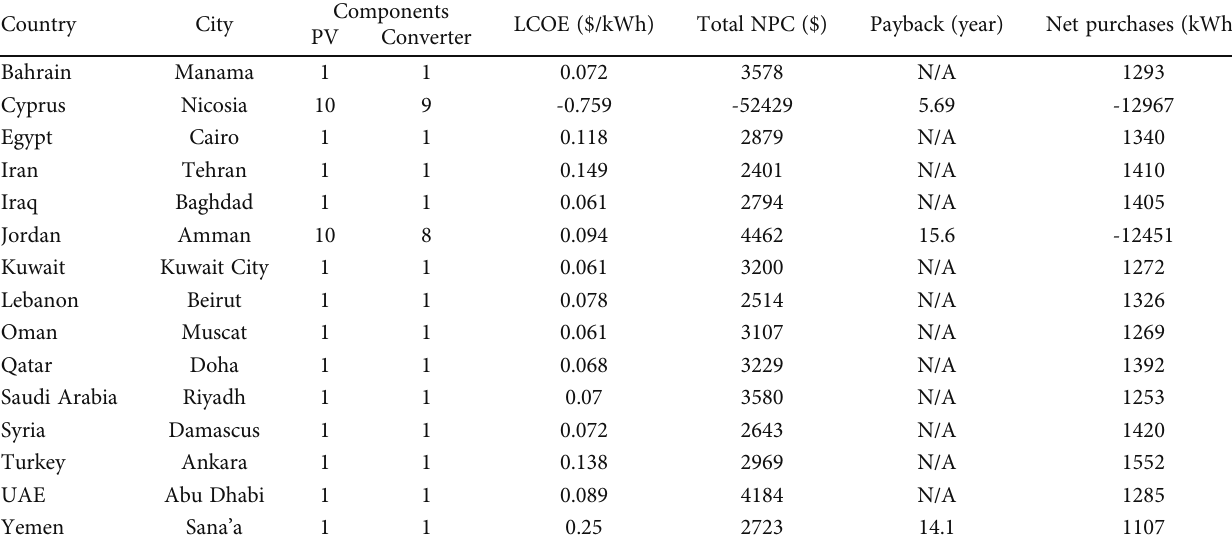
Table 5: Results of economical assessment.